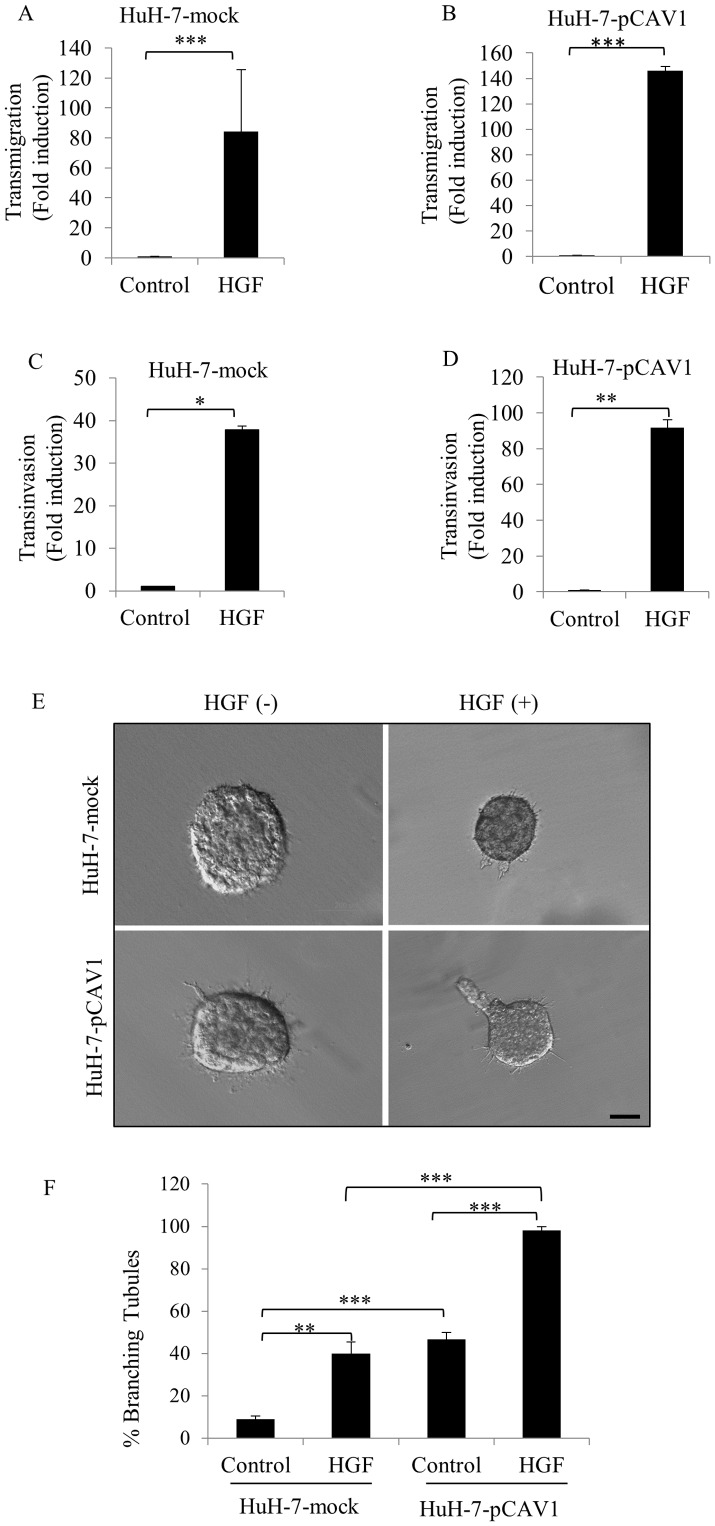
Ectopic expression of CAV1 enhanced c-Met signaling to drive cellular motility and invasion and branching morphogenesis in response to HGF stimulation.Cells transfected with mock or CAV1 plasmid were treated with or without HGF and then tested in migration and invasion assays. The cells that migrated and invaded through membrane were stained, counted under a light microscope at 25× magnification. The results are representative of three independent experiments, done in quadruplicate. Fold change were calculated by data from non-induced conditions. Bars represent fold change in mean number ± S.E. of migrating and invading cells; A. HuH-7-mock, B. HuH-pCAV1 and invading cells; C. HuH-7-mock, D. HuH-7- pCAV1 Student's t-test was used in the comparison of the means of non-induced and HGF-induced conditions. E. Branching-morphogenesis assay performed by HuH-7-mock and HuH-7-pCAV1 cells in DMEM supplemented with or without HGF. F. Columns shows mean number ± S.E derived from three separate experiments done in quadruplicate. ANOVA was used in comparison of groups. (***p<0,0001, **p<0,001, *p<0,05; Bar: 200 µm.).